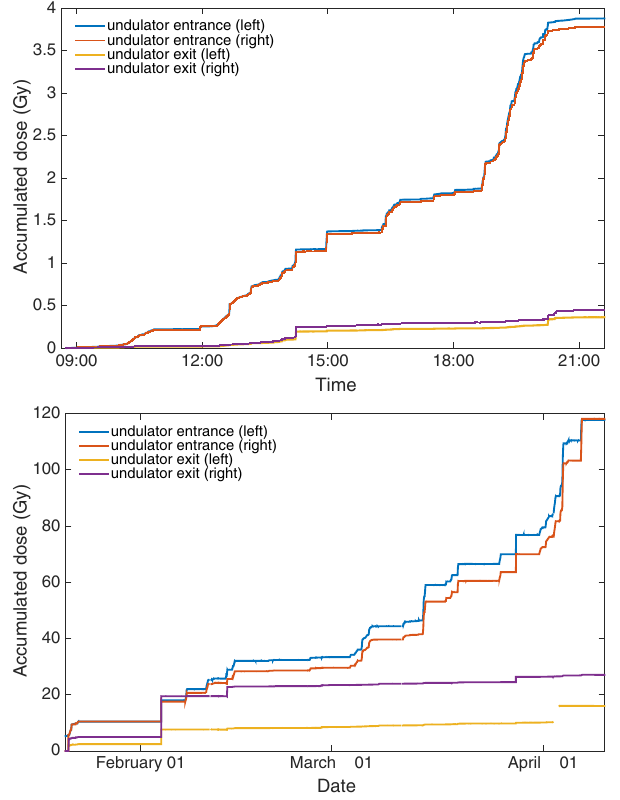
FIG. 40. Top: Snap-shot of the first day of RADFETs monitor- ing radiation exposure of the undulator. The four curves corre- spond to the four RADFETs installed at the undulator entrance and exit. Significant doses (of the order of a Gray) can be accumulated in a few minutes, demonstrating the need for a fast interlock. When the machine settings are properly adjusted the remaining losses are moderate. Bottom: RADFETs monitor data for the entire period of the undulator